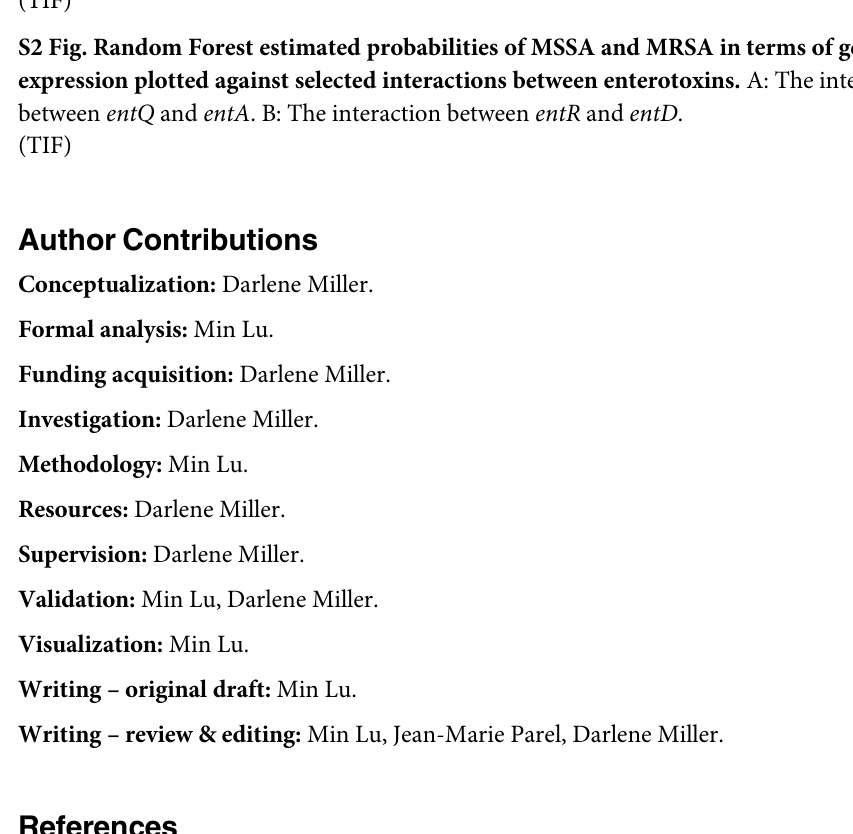
S5 Table. Informative virulence genes for predicting the phenotypic expression of MDR S. aureus . (DOCX) S1 Fig. Adjusted probability of the genotypic expression of MRSA from Random Forest prediction plotted against candidate virulence genes. A: Higher prevalence of enterotoxin P in MRSA isolates after adjusting for other virulence genes. In other words, entA (N315) / entP positive is associated with MRSA. B: After adjusting for other virulence genes, ssl05/set3 (RF122, probe-611) positive is associated with MRSA. C: After adjusting for other virulence genes, ssl07/set1 (MRSA252) negative is associated with MRSA. (TIF) S2 Fig. Random Forest estimated probabilities of MSSA and MRSA in terms of genotypic expression plotted against selected interactions between enterotoxins. A: The interaction between entQ and entA . B: The interaction between entR and entD .